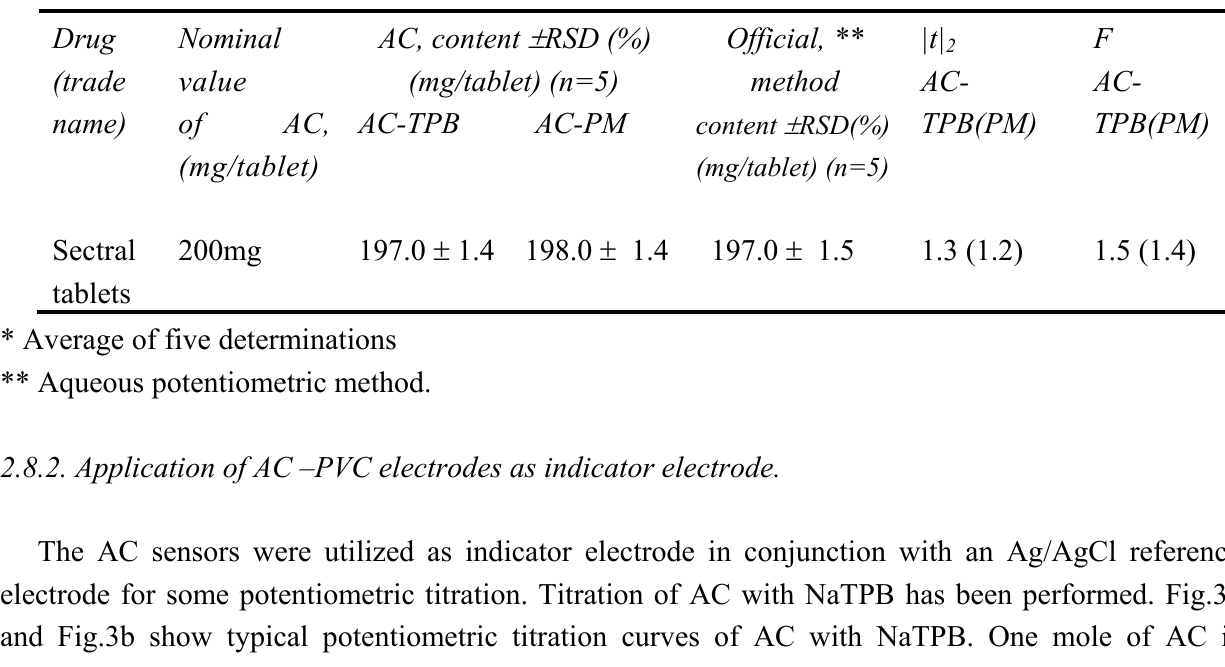
Table 5. Determination of AC in some pharmaceutical preparations using the proposed PVC membrane